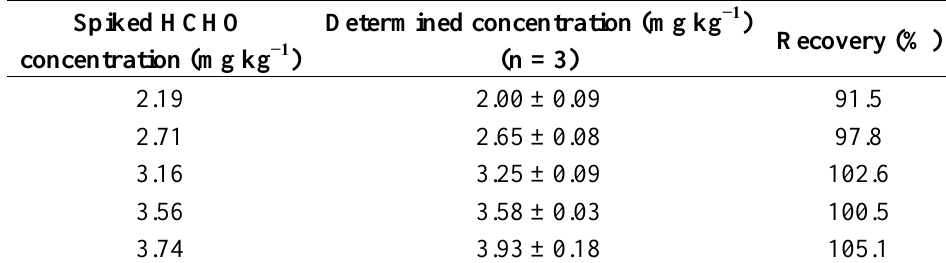
Table 6. Recovery performance of AOX-poly(nBA-NAS) microspheres based biosensors in the analysis of formaldehyde in shrimp